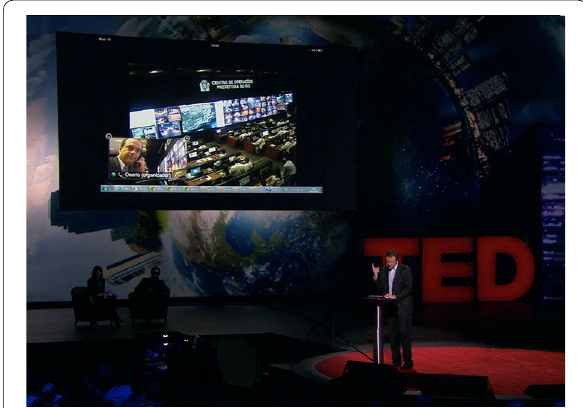
Fig. 1 Still from Eduardo Paes talk at TED in California 2012. From https:// ted. com